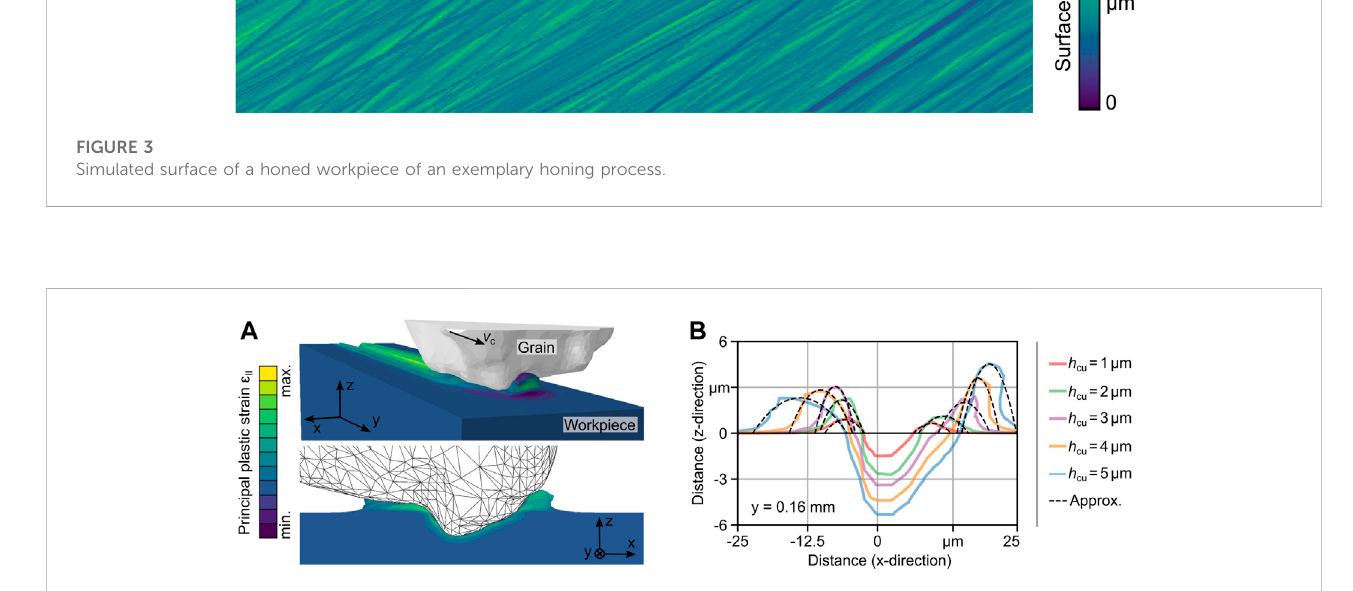
FIGURE 4 (A) FEmodelofthegainengagementwithanundeformedchipthickness ofh cu =5 μ m. (B) Cross-sectionalchipshapeandpro fi lesofdisplacedmaterial for different undeformed chip thicknesses and approximation of the burr